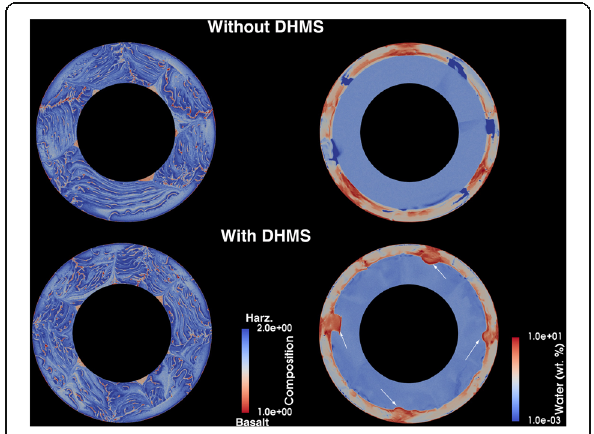
Fig. 3 1D horizontally averaged mantle water content with and without DHMS solubility as a function of pressure scaled as GPa